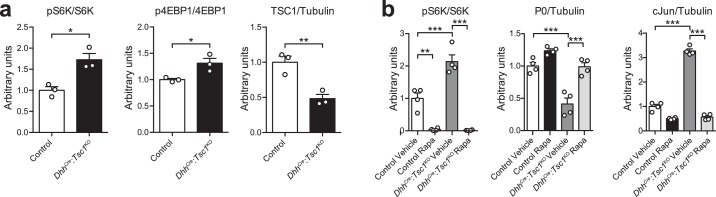
Quantification of western blots.Bar height: mean; error bars: s.e.m. (a) Quantification referring to Figure 1a. Control average is set to 1 (n = 3 mice/genotype, including the biological replicates representatively shown in Figure 1a, two-tailed unpaired Student’s t-test; pS6K/S6K, t(4) = 4.233, p=0.0133; p4EBP1/4EBP1, t(4) = 3.26, p=0.0311; TSC1/Tubulin, t(4) = 4.854, p=0.0083). (b) Quantification referring to Figure 1k. Vehicle-treated control average is set to 1 (n = 4 mice/condition, including the biological replicates representatively shown in Figure 1k, one-way ANOVA with Tukey’s multiple comparisons test; pS6K/S6K, F(3,12) = 56.94, p<0.0001, pcontrol vehicle vs rapamycin = 0.0013, pcontrol vehicle vs TSC1KO vehicle = 0.0003, pTSC1KO vehicle vs rapamycin <0.0001; P0/Tubulin, F(3,12) = 31.28, p<0.0001, pcontrol vehicle vs TSC1KO vehicle = 0.0001, pTSC1KO vehicle vs rapamycin = 0.0002; cJun/Tubulin, F(3,12) = 366.2, p<0.0001, pcontrol vehicle vs TSC1KO vehicle <0.0001, pTSC1KO vehicle vs rapamycin <0.0001). *p<0.05, **p<0.01, ***p<0.001.